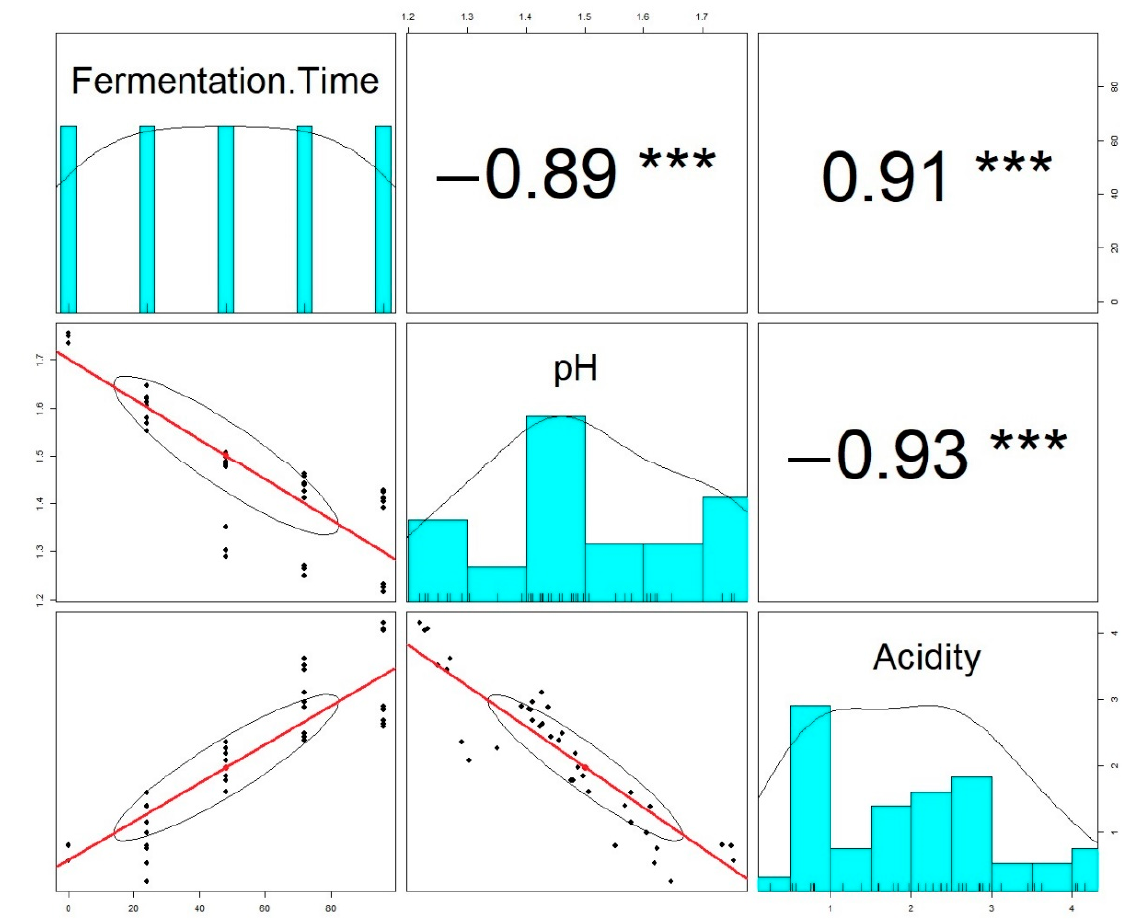
Figure 3. Correlation between fermentation time, pH, and acidity.